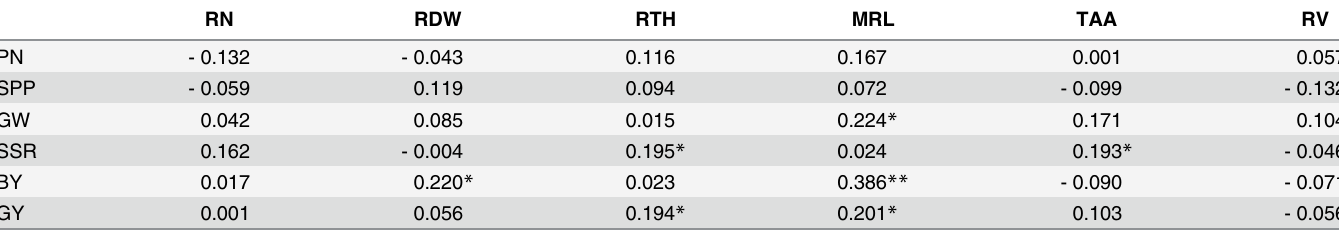
Table 3. Correlation analysis among seven root traits and six yield-related traits in the CSSL population.